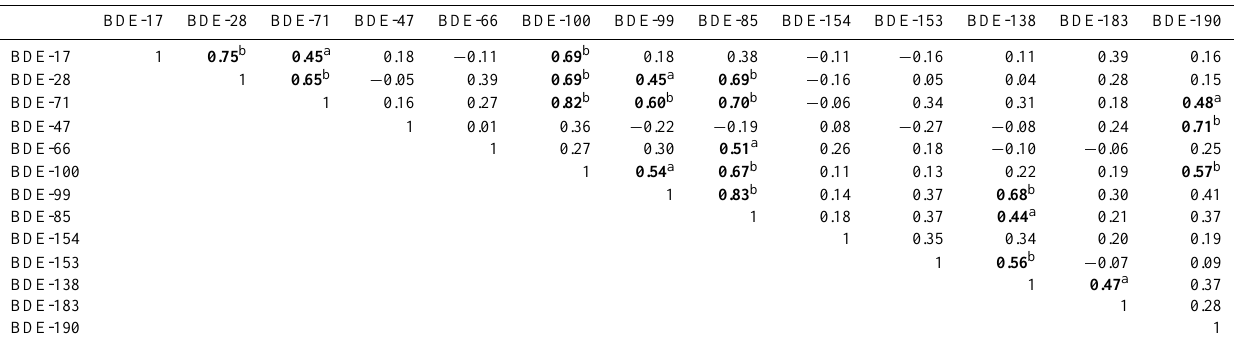
Figure 5. Comparison of theoretical K p based on adsorption (a) and absorption (b) in three modes with measured K p values by Yang et al. (2013) in Shanghai from 2008 to 2009. Table 4. Pearson correlation matrix for the concentrations of PBDE